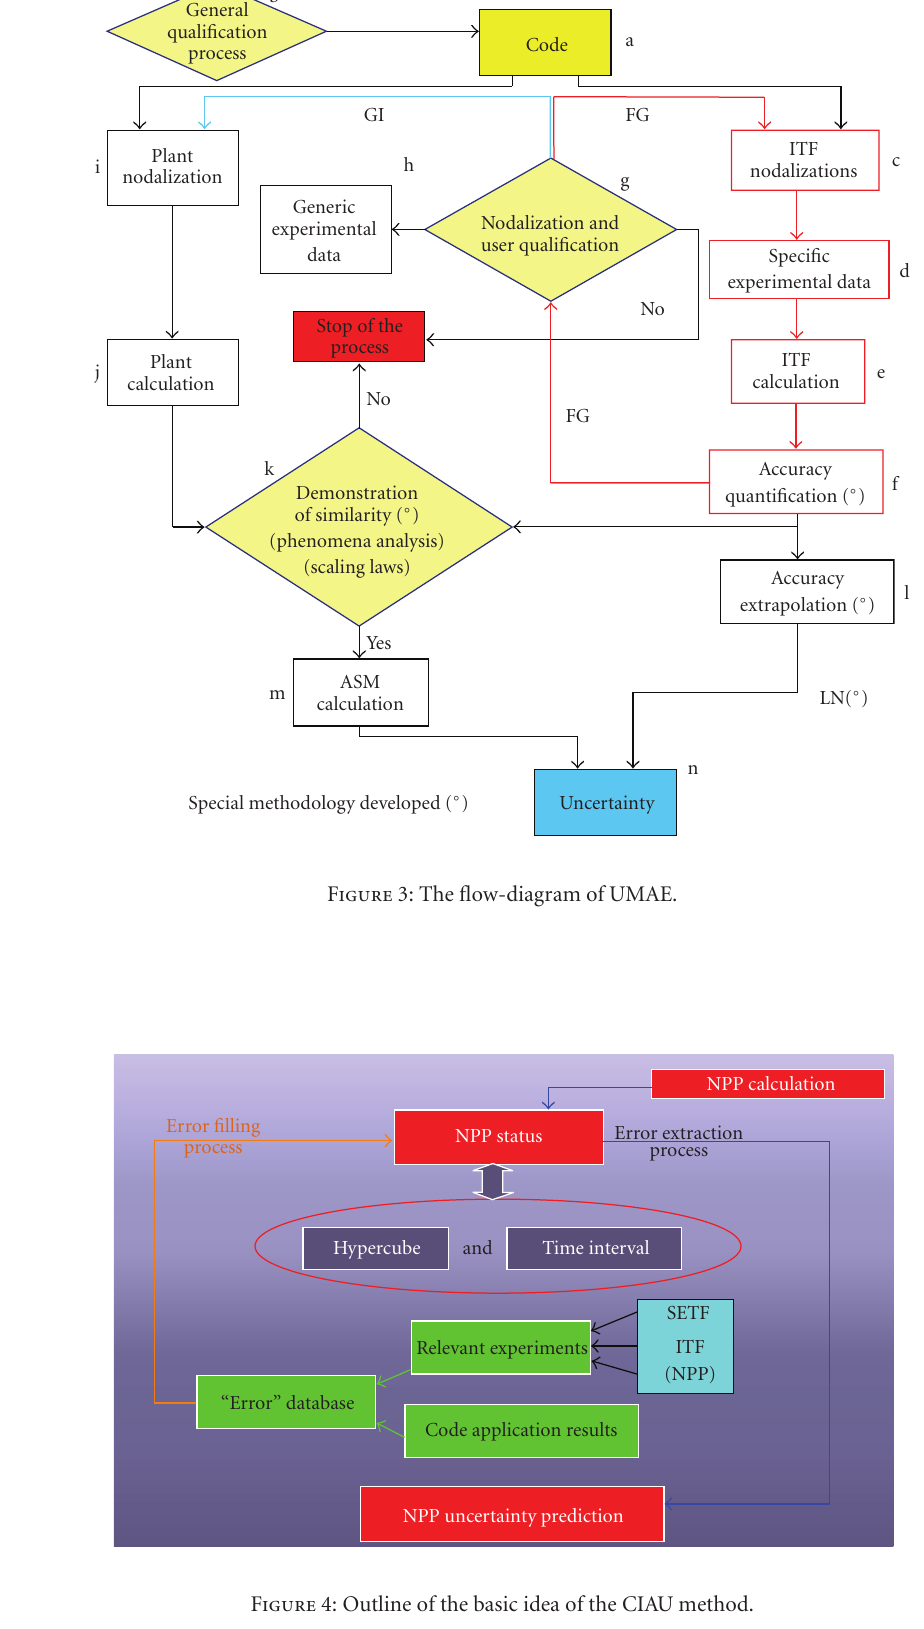
Figure 4: Outline of the basic idea of the CIAU